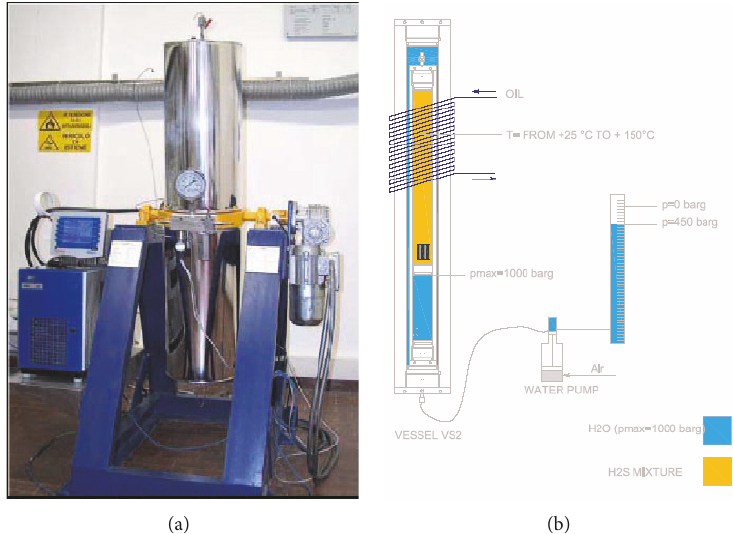
Figure 4: Ultrahigh pressure autoclave (a); pressurization and thermostatic circuits (b).